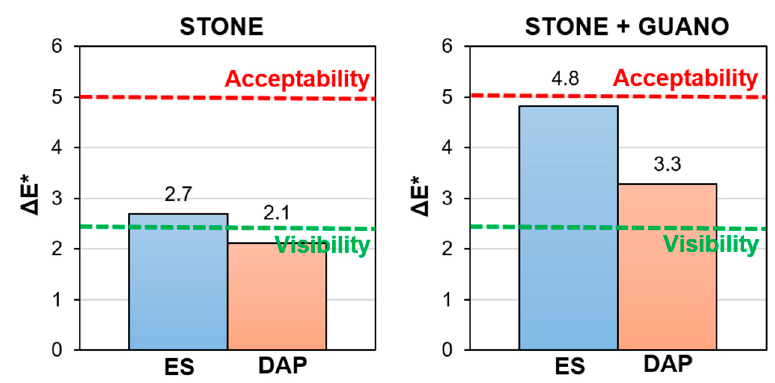
Figure 10. Color change ( ∆ E *) of stone (“ST”) and stone + guano (“ST + G”) specimens.